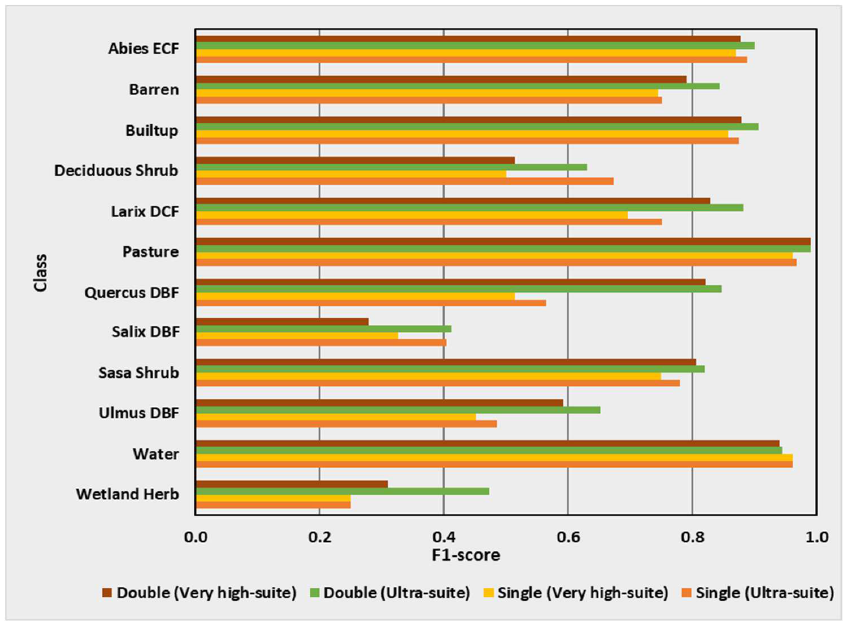
Figure 14. Class-wise changes in accuracy (F1-score) by addition of summer images in the Shiranuka site.